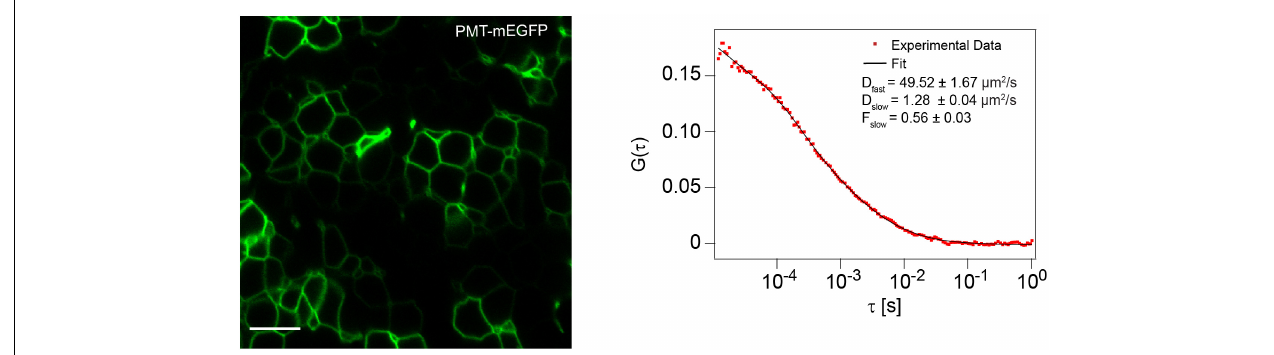
FIGURE 6 | Membrane localization and dynamics of PMT-mEGFP Cell membrane localization of PMT-mEGFP (left) and a representative autocorrelation function (ACF; dots) and fit (line) of FCS measurement at the cell membrane (right). The FCS curves were fitted using 2D-2particle-1triplet model. Scale bar 10 µ